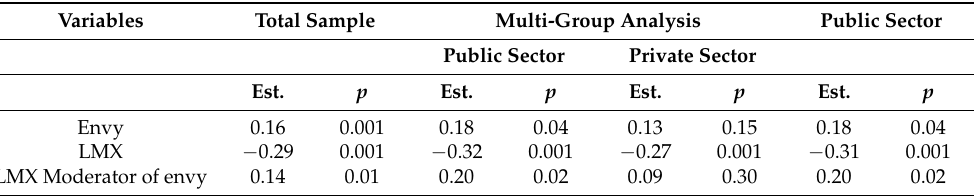
Figure 2. Results of path analysis for the model in the total sample, public sector, and private sector. Note: LMX = Leader Member Exchange; CWB = Counterproductive Work Behavior. Table 4. Standardized Path analysis effects.